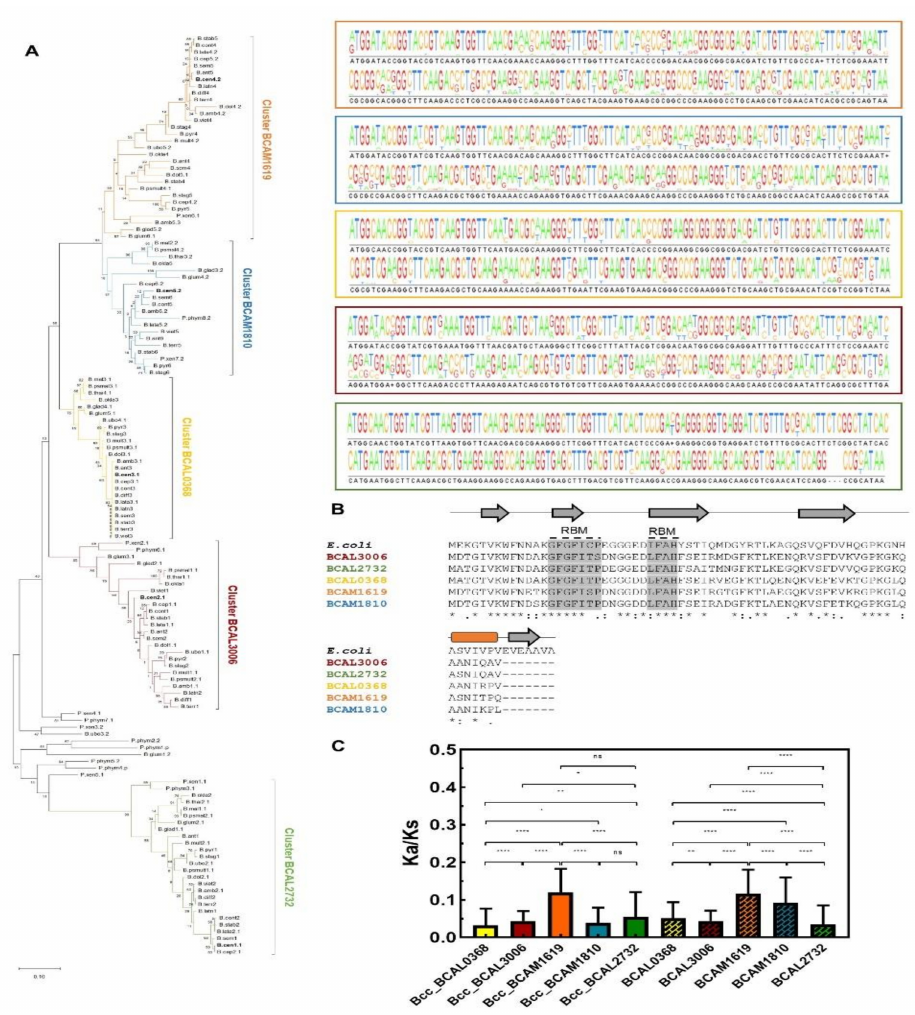
Figure 5. The cold shock-like proteins encoding genes from bacteria of the Burkholderia genus. ( A ) Phylogenetic tree constructed based on the analysis of 135 nucleotide sequences listed in Table S3. The evolutionary relatedness was inferred using the Maximum Likelihood method and Tamura–Nei model and conducted on MEGA X. The tree with the highest log likelihood ( − 6068.10) is shown. The percentage of trees in which the associated taxa clustered together is shown next to the branches. Initial tree(s) for the heuristic search were obtained by applying the neighbor-joining method to a matrix of pairwise distances estimated using the maximum composite likelihood (MCL) approach. The tree is drawn to scale, with branch length units as the number of base substitutions per site. Upper panels: representation of the consensus sequences, determined by the alignment of the Burkholderia Csps genes clustered in Cluster BCAM1619 (orange), BCAM1810 (blue), BCAL0368 (yellow), BCAL3006 (brown), or BCAL2732 (green), as a sequence logo in which the size of each nucleotide with the black background corresponds to its degree of conservation. ( B ) Alignment of the amino acid sequences of the cold shock-like proteins from B. cenocepacia J2315 and the E. coli CspD (b0880). Asterisks (*) indicate identical amino acid residues, one (.) or two dots (:) indicate semi-conserved or conserved substitutions, respectively. The predicted secondary structure of E. coli CspD protein is shown above the alignment segment, where cylinders represent α -helices and arrows represent β -sheets. Alignments and secondary structure predictions were performed with MUSCLE and PSIPRED software, respectively. RBM: RNA binding motif. ( C ) Mean Ka / Ks values of the di ff erent Bcc (colored bars without pattern) or Burkholderia species (bars with pattern), calculated using orthologs csps genes. Error bars indicate the standard deviation. The p -values were determined with the two-tailed Mann–Whitney test and represented by * when p < 0.05, ** when p < 0.01, **** when p < 0.0001, or